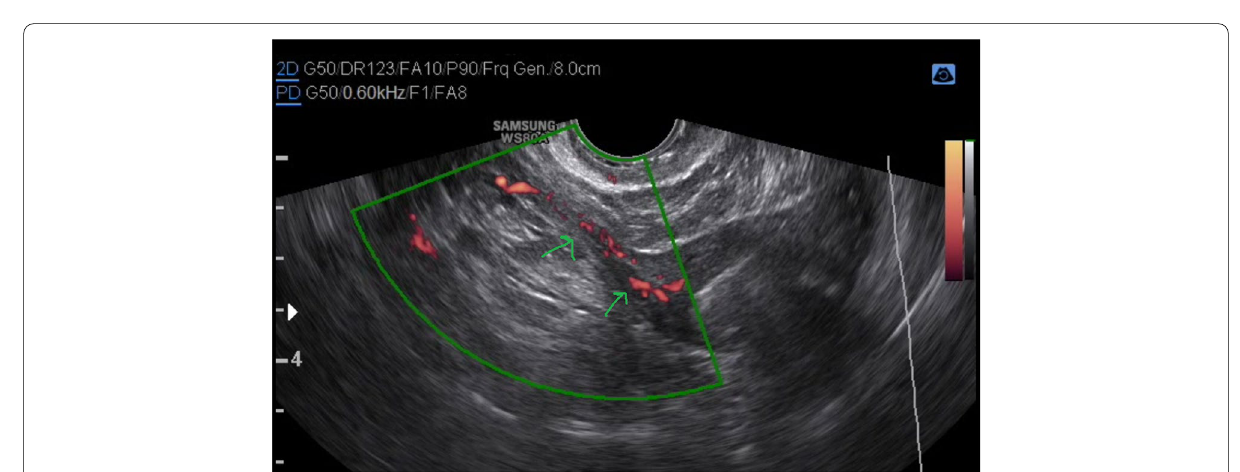
Fig. 2 Power Doppler showing the patent left fallopian tube with foam